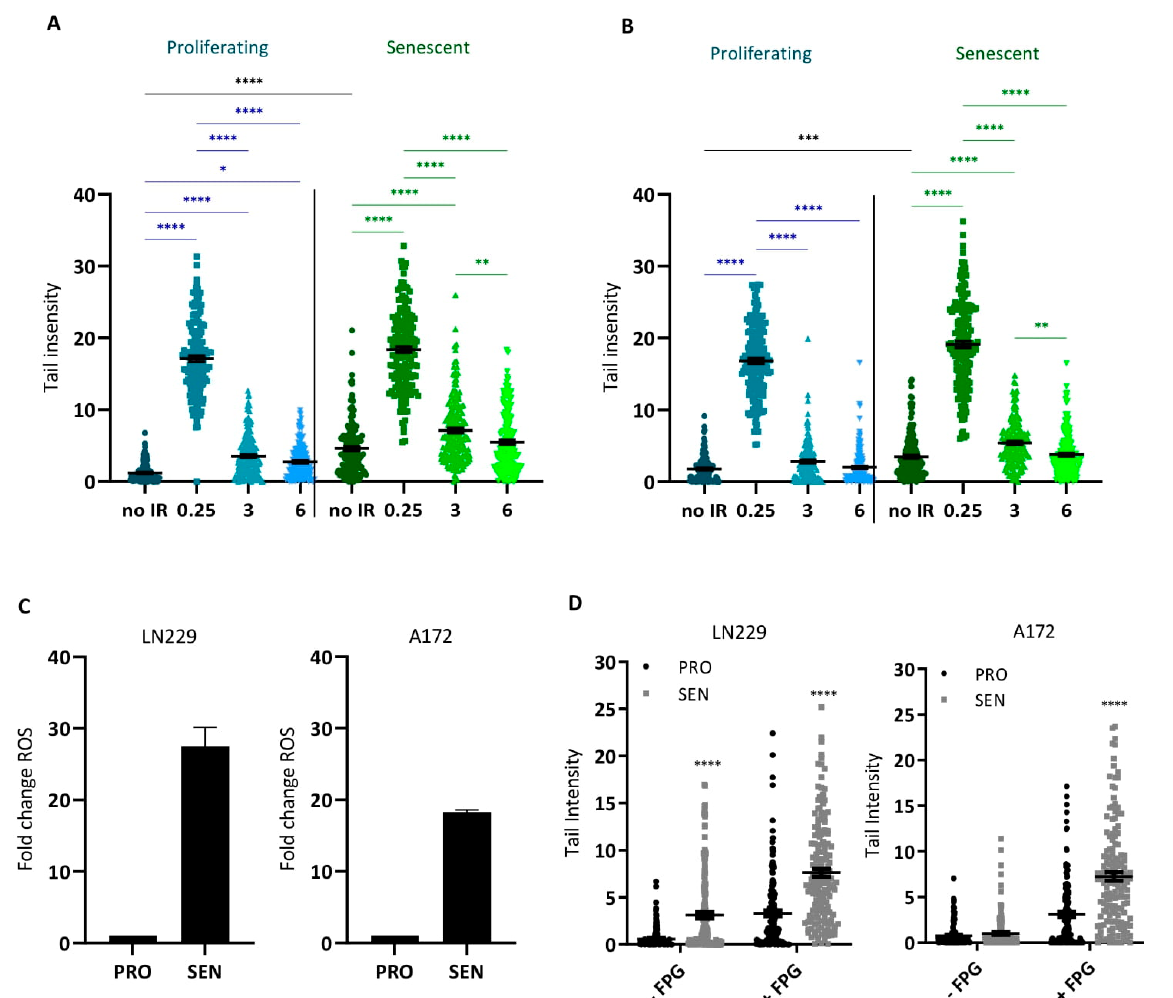
Figure 4. DSBs and oxidative stress in the proliferating and senescent cell population. ( A , B ) DSBs were measured immediately (0.25 h) after IR (6 Gy) and 3 and 6 h thereafter. Neutral comet assay of nonirradiated and irradiated proliferating and senescent LN229 ( A ) and A172 ( B ) cells. Bars indicate the median ± SEM of three independent experiments. For each experiment, 50 cells were analyzed. * p < 0.05, ** p < 0.01, *** p < 0.001, **** p < 0.0001. ( C ) ROS level in exponentially growing (control) and CSEN cells. ( D ) Alkaline comet assay in the absence and presence of FPG protein on proliferating and CSEN cells. The differences between control and CSEN were highly significant.